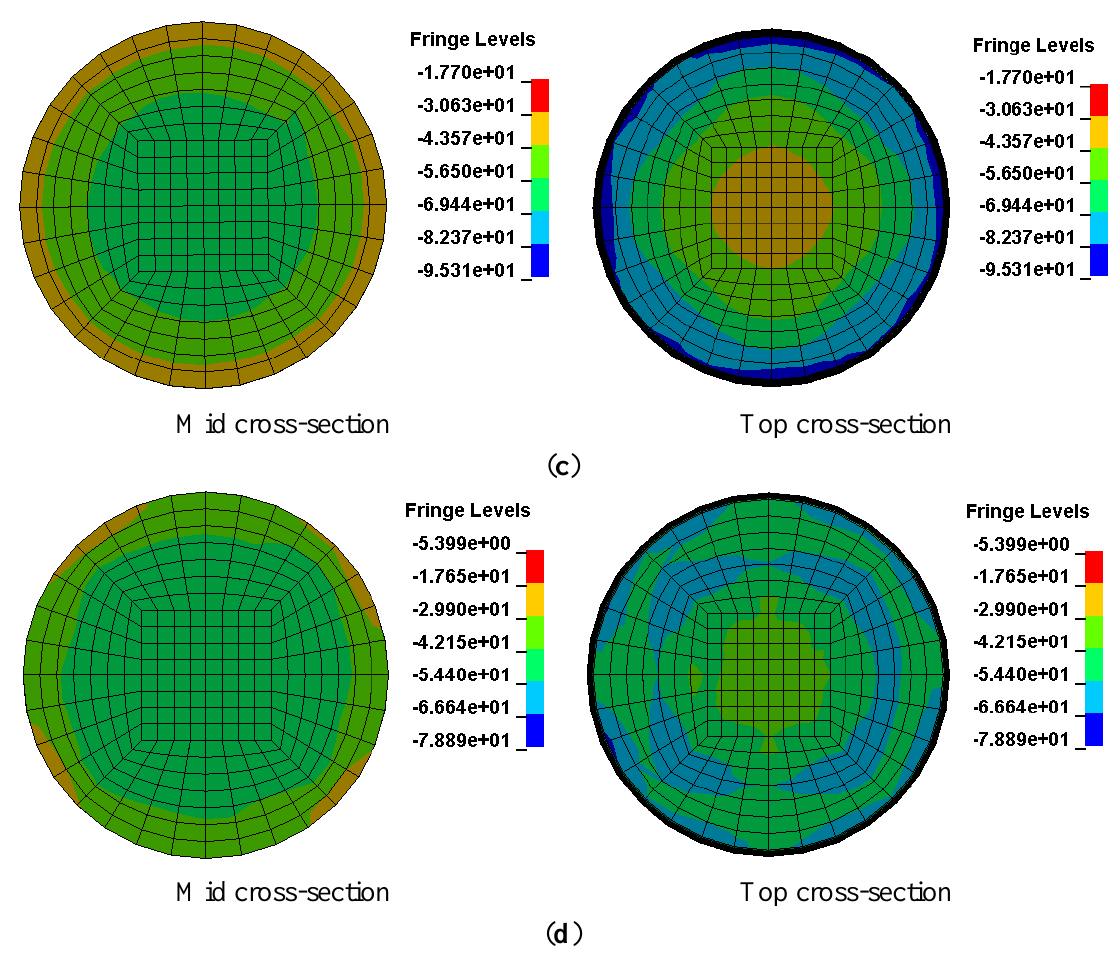
Figure 9. Axial stress in cross-section of the columns of sizes: ( a ) 150 mm × 300 mm; ( b ) 200 mm × 100 mm; ( c ) 300 mm × 600 mm; and ( d ) 1500 mm × 3000 mm. Note: